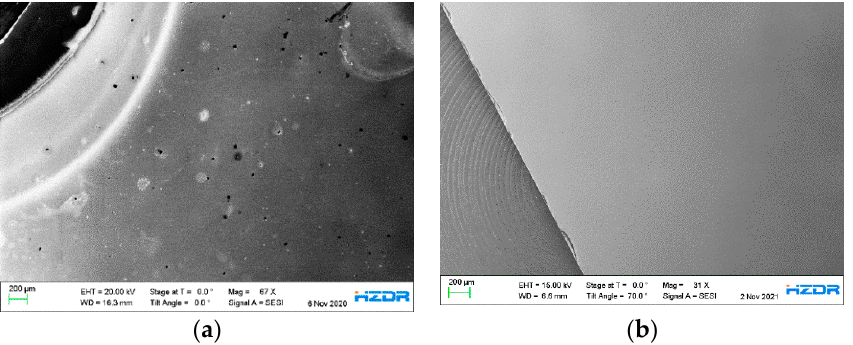
Figure 7. ( a ) SEM overview image of a part of the p-GaN:Cs photocathode (sample A1), which was thermally cleaned above 600 °C and activated for four cycles; ( b ) SEM overview image of a part of the p-GaN:Cs photocathode (sample A5), which was thermally cleaned at 500 °C and activated for five cycles.